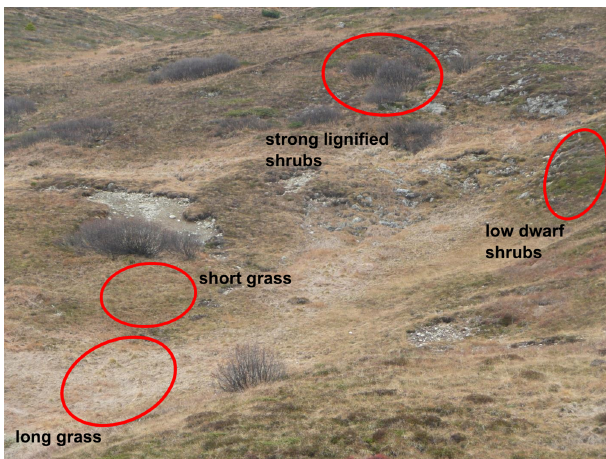
Figure 3. Different vegetation types were observed in our field campaign. The main types were long grass, short grass, low dwarf shrubs and strong lignified